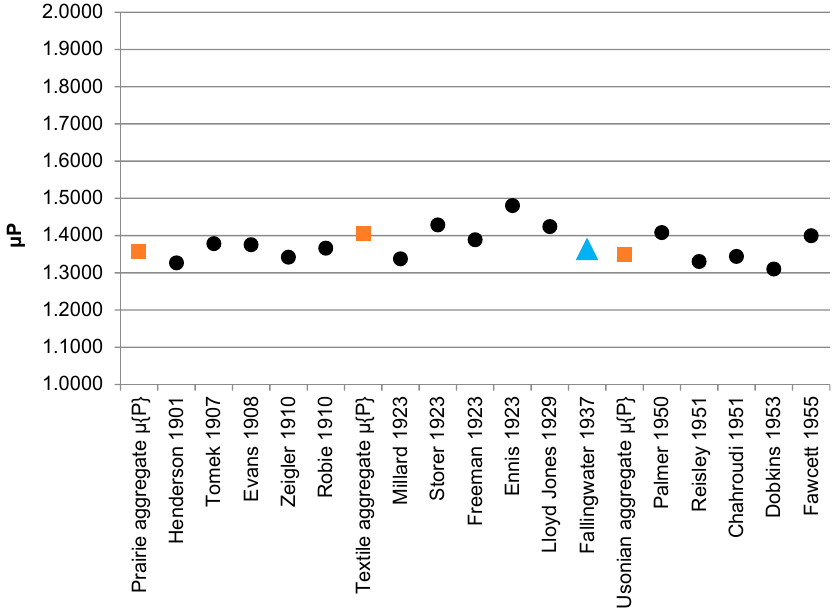
Figure 10. Plan results: mean [ • ]and aggregate [ (cid:4) ] D compared with Fallingwater [ (cid:78)